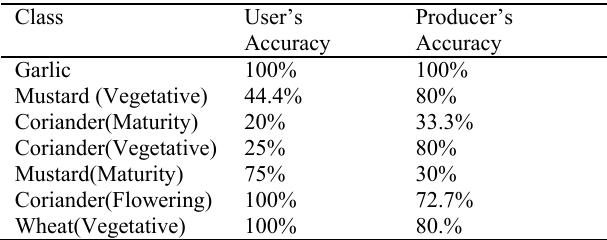
Table 3. Accuracy Assessment